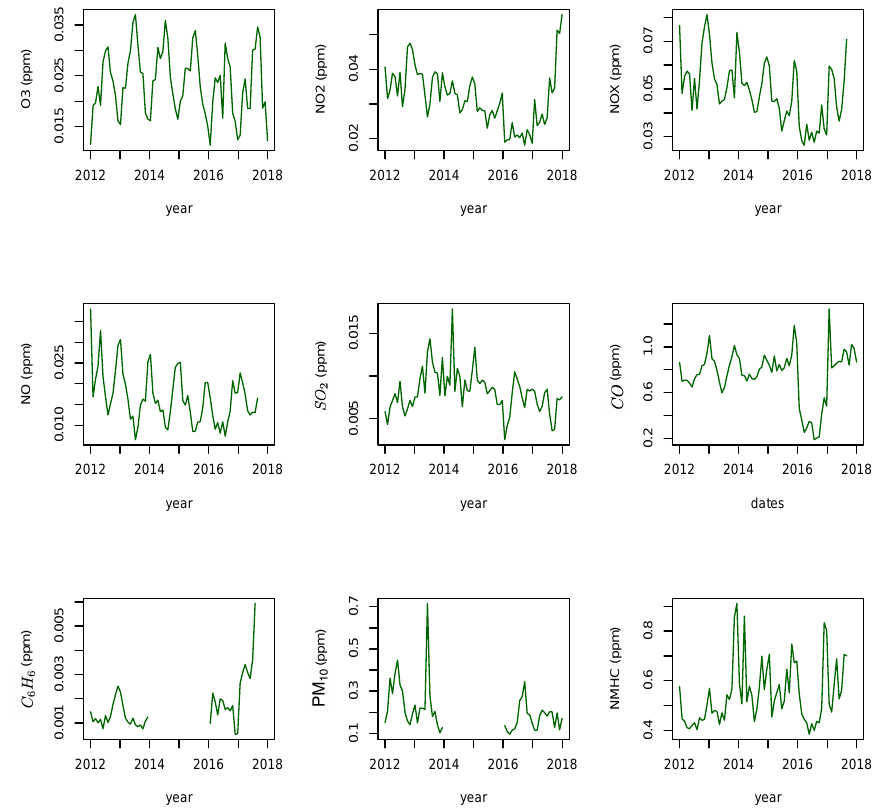
Figure 3. Time series of the Studied Pollutants from 2012 to 2017— EPA